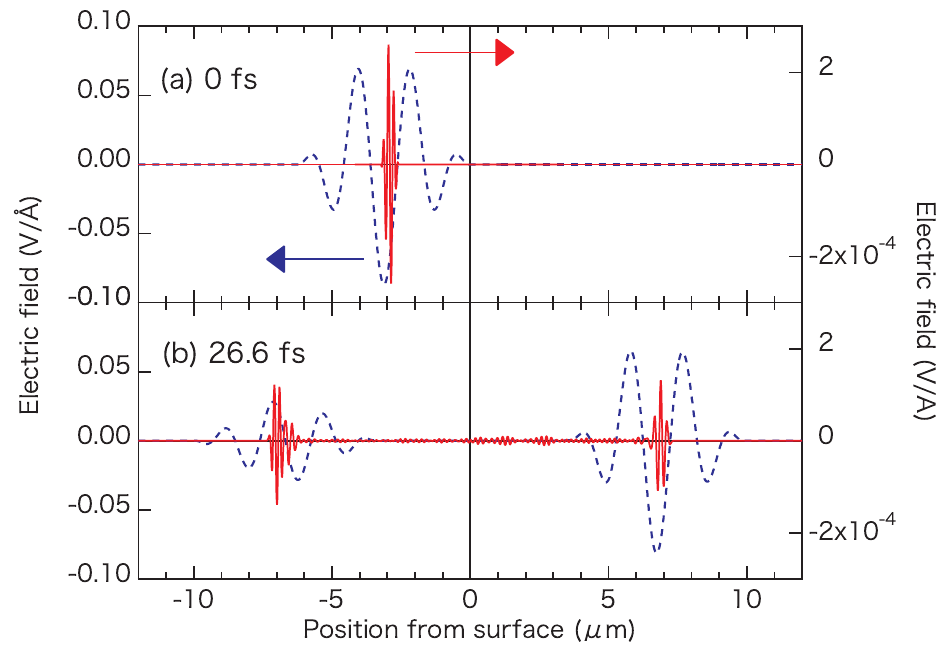
Figure 1. The laser field of the pump (blue-dashed line) and probe (red-solid line) as the function of the position from the surface. ( a ) Incidental laser fields at time 0 fs. ( b ) Transmitted and reflected laser fields at time 26.6